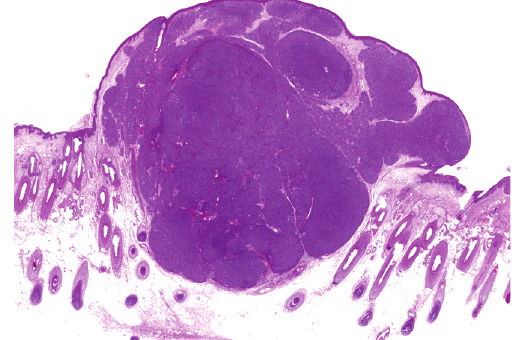
Figure 3: A well-circumscribed, smooth-bordered, and deeply basophilic tumor in the dermis.